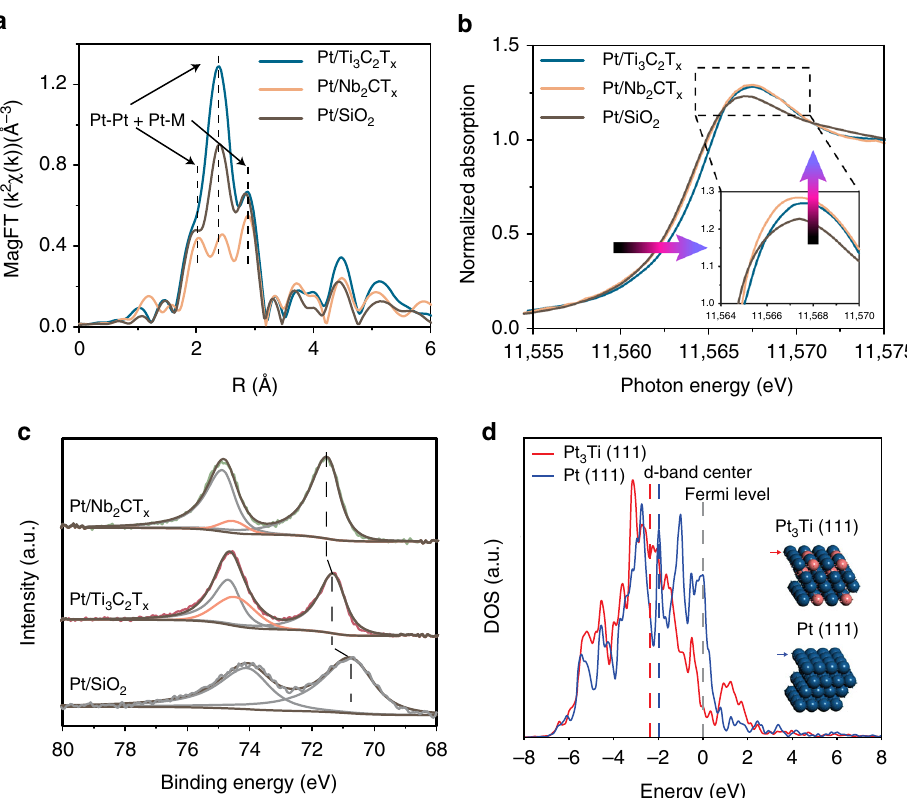
Fig. 3 In situ Spectroscopy characterization of Pt/MXenes catalysts. a Magnitude of the Fourier Transform of the k 2 weighted Pt L III edge in situ EXAFS of the Pt/Ti 3 C 2 T x and Pt/Nb 2 CT x catalyst after reduction at 550 °C in H 2 compared to Pt/SiO 2. b The Pt L III edge in situ XANES spectra of the Pt/Ti 3 C 2 T x and Pt/Nb 2 CT x catalyst after reduction at 550 °C in H 2 compared to Pt/SiO 2 . c XPS spectra of Pt/Ti 3 C 2 T x , Pt/Nb 2 CT x and Pt/SiO 2 reduced at 550 °C by H 2 in a spectrometer side chamber and not exposed to air. d DFT calculated projected density of states (DOS) for the 5 d orbitals of Pt in the top-layer Pt 3 Ti